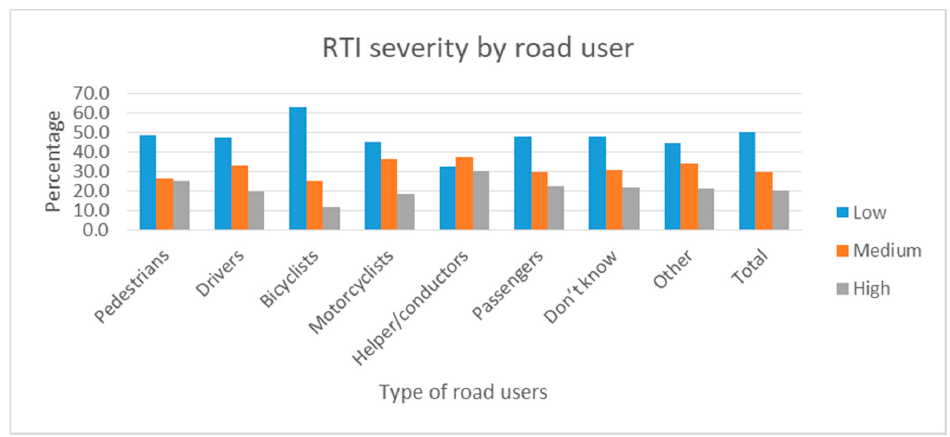
Figure 4. Injury severity index related to road user in RTI morbidity.